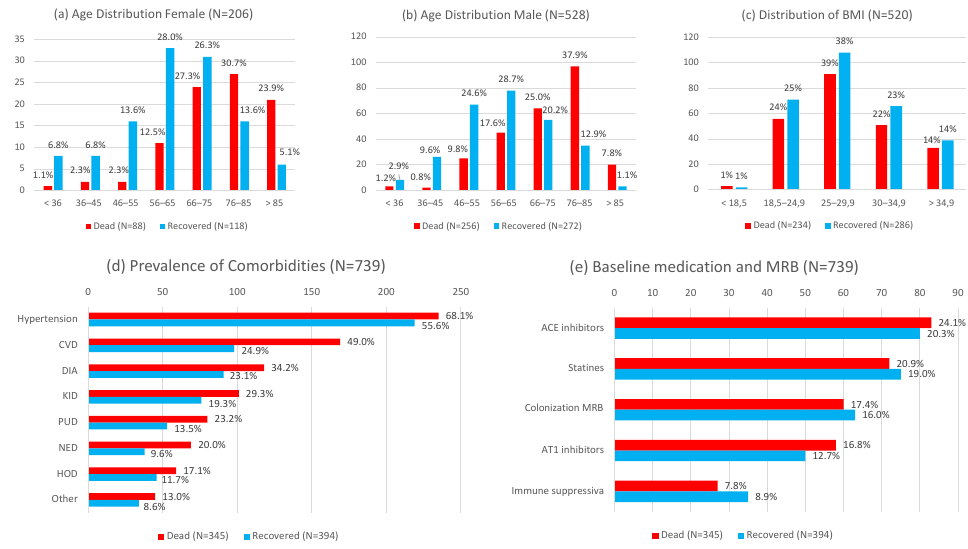
Figure 1. Distribution of baseline values. All axes show absolute frequencies, and percentages are given relative to the subgroup of recovered (blue bars) and dead patients (red bars). Of N = 739 patients included in the study, 394 ( 53.3% ) recovered and 345 ( 46.7% ) died. ( a ) Age distribution of female patients. Overall, 88 of 206 ( 42.7% ) female patients died. ( b ) Age distribution of male patients. Overall, 256 of 528 ( 48.5% ) male patients died. For both genders, the percentage of fatal outcomes increased with age. ( c ) Distribution of the body mass index (BMI) of N=520 patients. Data from remaining patients were missing. Three quarter of the patients were overweight or obese. The distribution of BMI for recovered and dead patients was practically identical. ( d ) Prevalence of comorbidities. Hypertension was the most common comorbidity, both in recovered and dead patients. The largest difference between recovered and dead patients was observed for cardiovascular disease. Generally, all prevalences are higher for patients who died than for patients who recovered. ( e ) Baseline medication and colonization with multi-resistant bacteria (MRB). ACE inhibitors was the most frequently used class of medication observed at baseline for recovered and dead patients, followed by statins. Generally, the differences in medication and known colonization with MRB between dead and recovered patients were